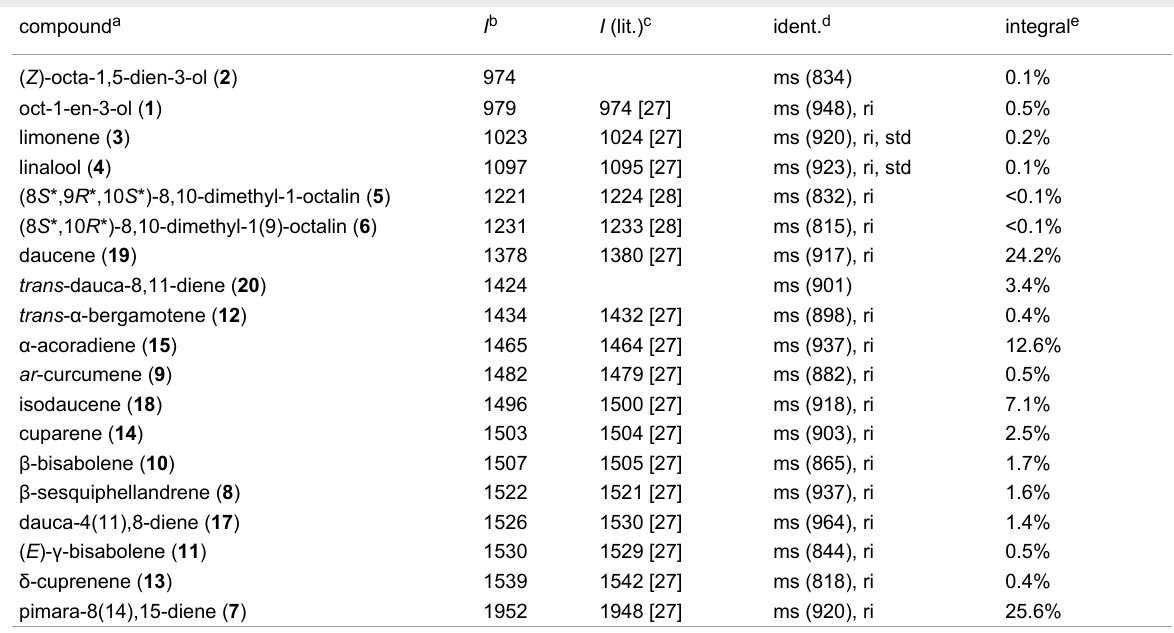
Table 1: Volatiles emitted by Aspergillus fischeri NRRL